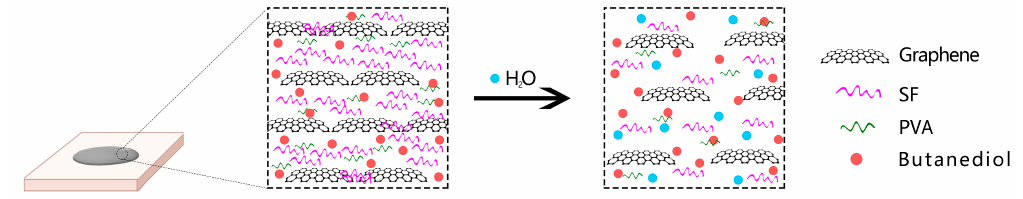
Figure 7. Swelling mechanism of SF/GrP/BD Film.